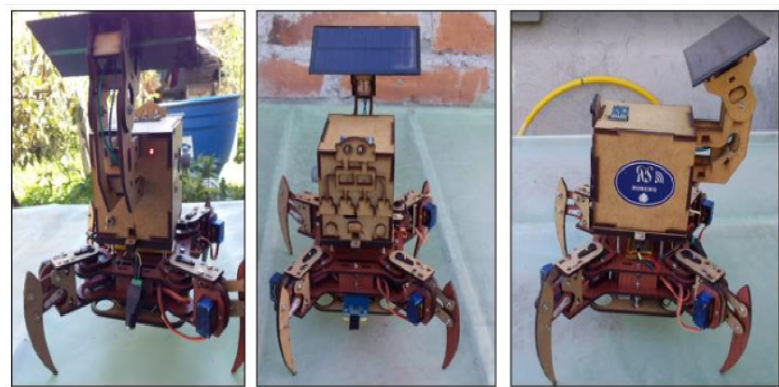
Figure 7. Implementation of the nodes onto the autonomous